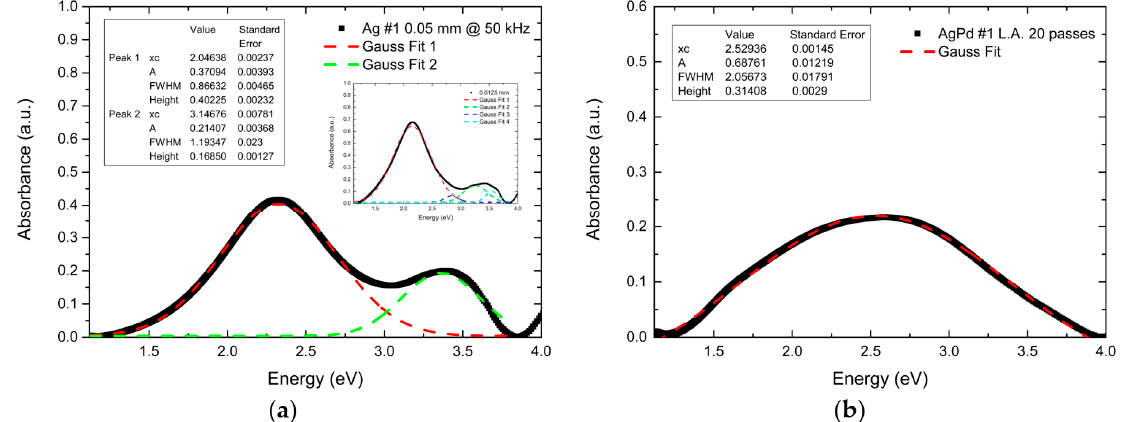
Figure 1. Indicative absorbance spectra and Gaussian fittings of the LSPRs for Ag films and AgPd multilayers after background subtraction. ( a ) The area of the Ag #1 (13.5 nm) film irradiated with a fill spacing of 0.05 mm at 50 kHz ; the inset concerns the area of the same film irradiated with a fill spacing of 0.0125 mm at 60 kHz . ( b ) The area of the AgPd #1 (7.5 nm) multilayer irradiated with 20 laser passes . LSPRs are shown to follow a Gaussian curve. Ag films exhibited two main LSPRs, and in some cases, three or even four peaks were visible, as depicted in the inset of ( a ). This will be discussed further below. AgPd multilayers, however, exhibited only one LSPR, as shown in ( b ). The LSPR position (xc), intensity of the plasmonic response (A), amplitude of the plasmonic resonance (Height), and full width at half maximum (FWHM) are also presented as insets in both figures.